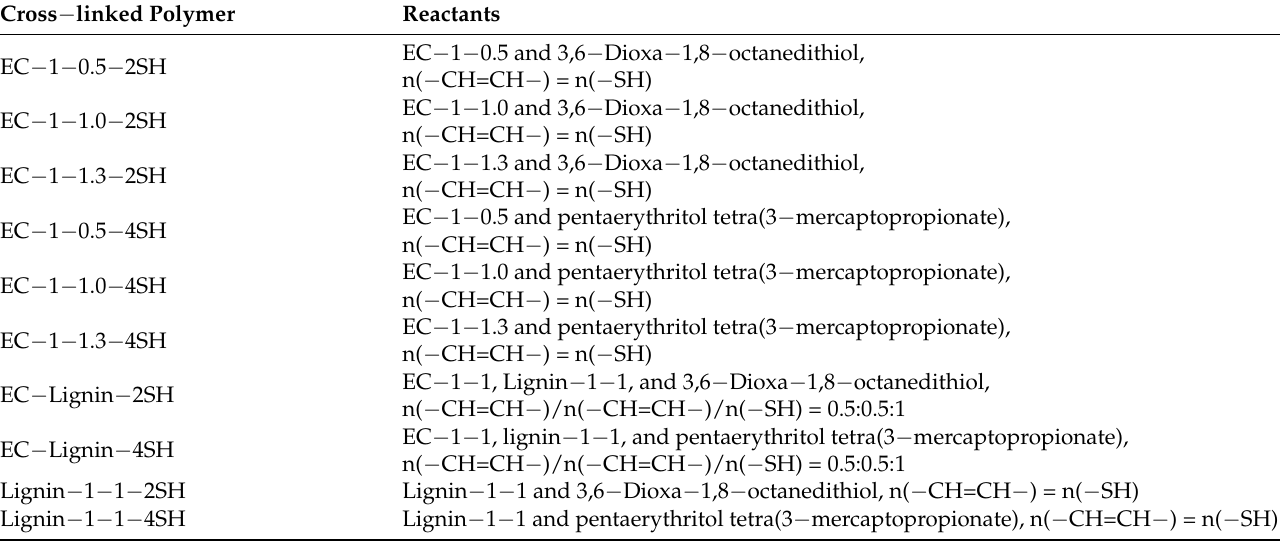
Table 1. Reactants and the obtained wood − derived